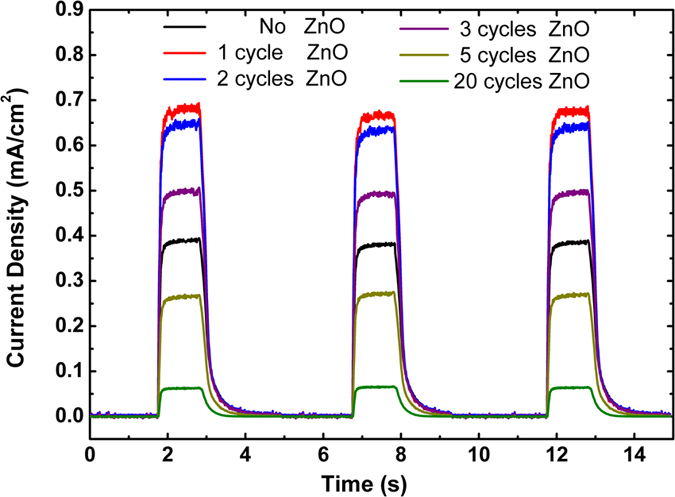
Photocurrent response of the bare and different cycles of ZnO coated TiO2 samples.